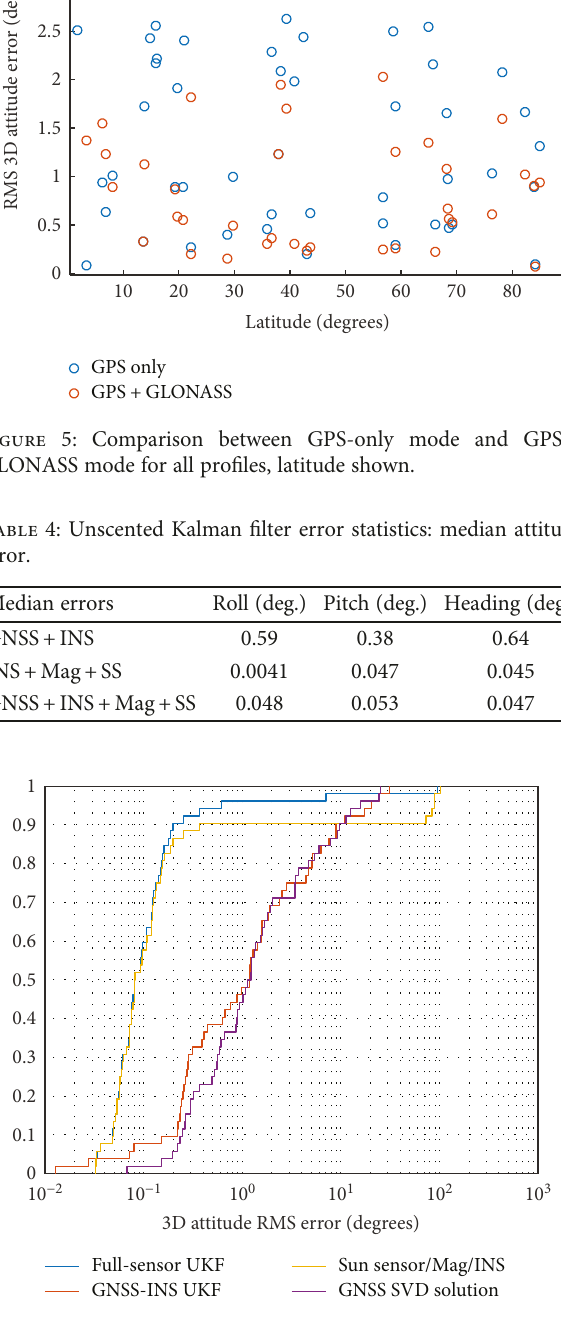
Figure 6: Comparison between GNSS-SVD solution and multisensor attitude fi lter in di ff erent modes — 3-axis attitude